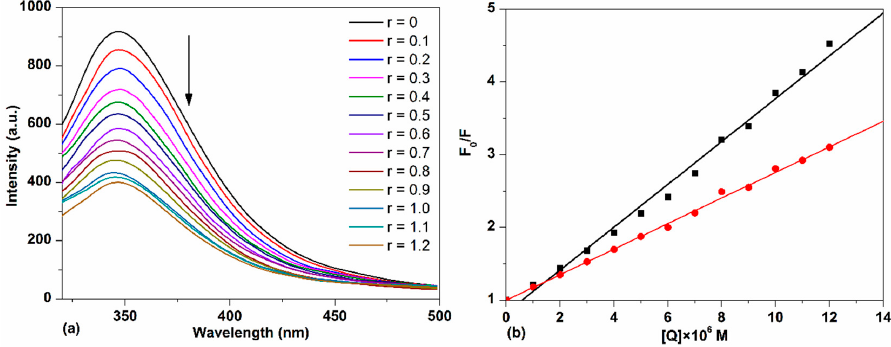
Figure 7. ( a ) Fluorescence spectra changes of HSA with the addition of TCPC ( r = [TCPC]/[DNA]) in Buffer IV (pH = 7.4); ( b ) the plots of F 0 / F vs. [TCPC] before ( dark line ) and after ( red line ) IFE (inner filter effect) correction.